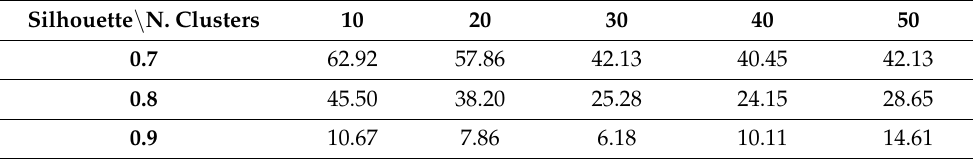
Table 25. Clustering performance in terms of silhouettes using original data. Silhouette \ N. Clusters